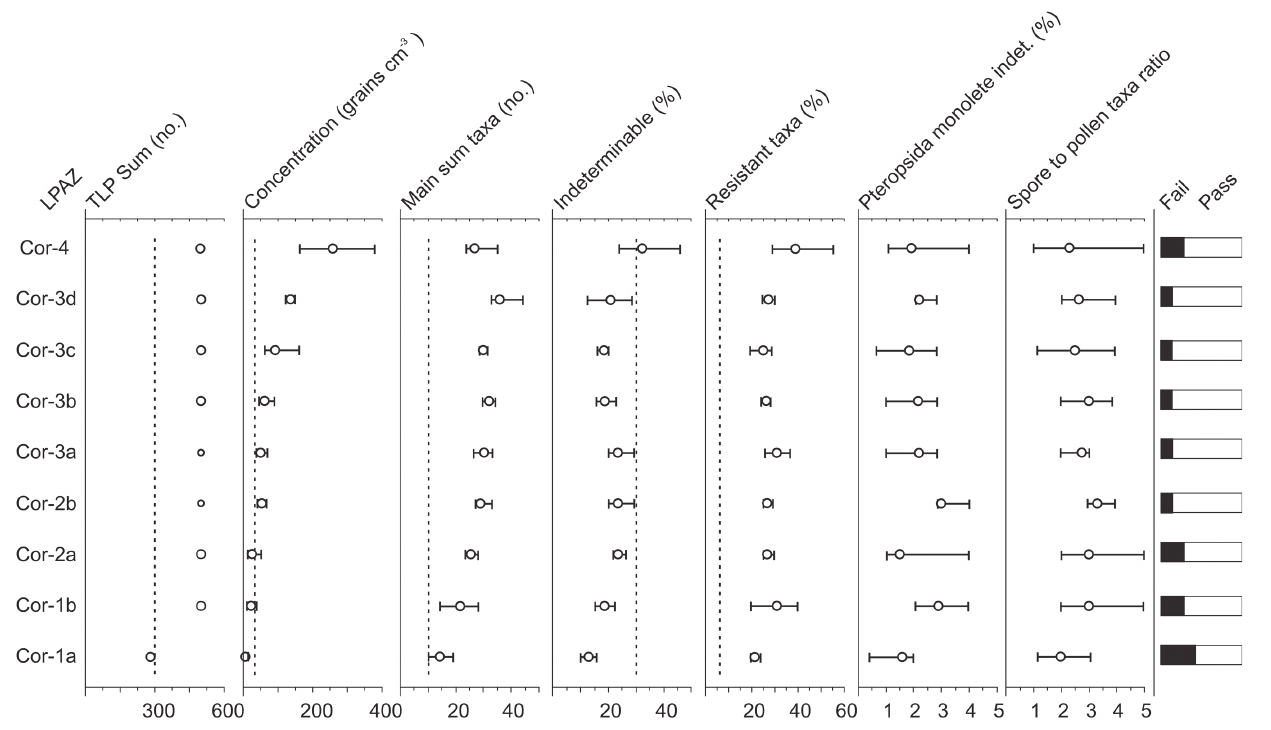
Fig 6. Assessment of the taphonomy of the core based on tests proposed by Bunting and Tipping (2000). Circles reflect the mean values with error bars indicating the maximum and minimum values for each LPAZ. Dashed lines indicate the tresholds below which samples fail each test expect in the case of Indeterminable percentages where values greater than the threshold indicate